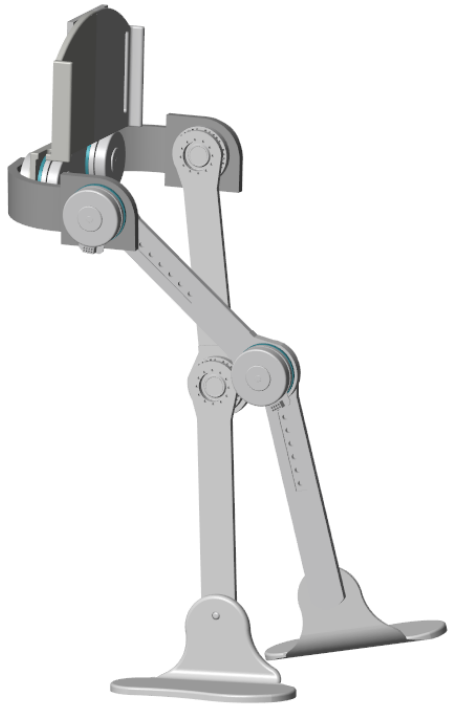
Figure 2. CAD of the exoskeleton robot for rehabilitation, ALICE.